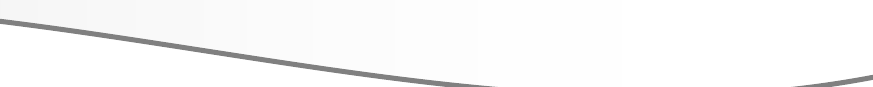
Table 1: Territorial identity quintessentialised in tourist destination branding ideas and proposals